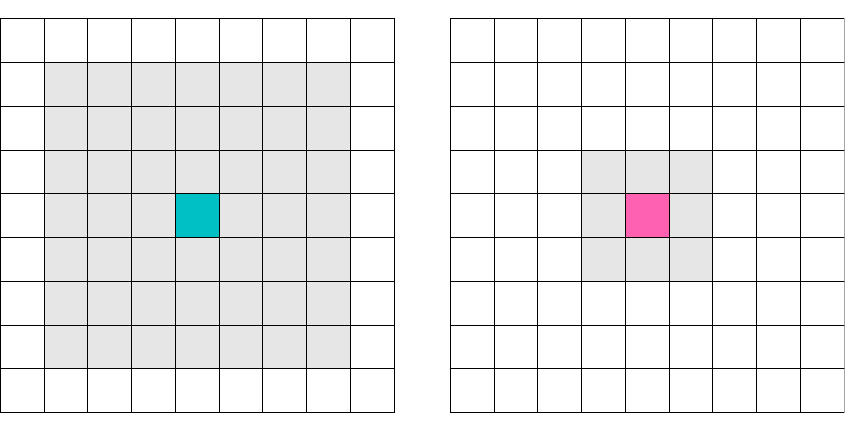
Figure 7. Moore neighborhood or radius: ( left ) prey; and ( right )